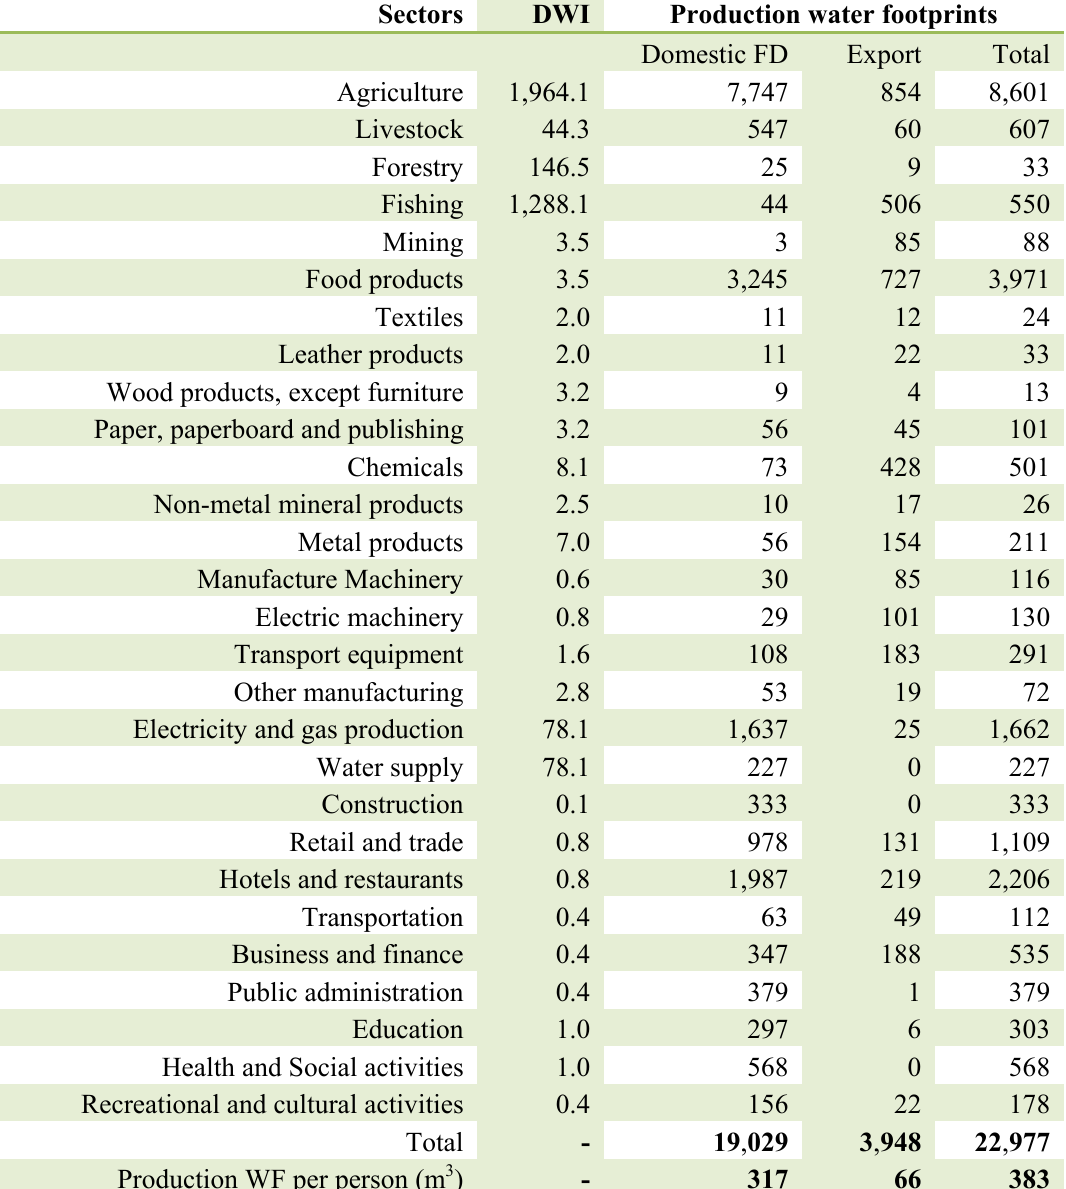
Table 2. UK direct water intensity (m 3 /£1000) and production water footprints (million m 3 ) by